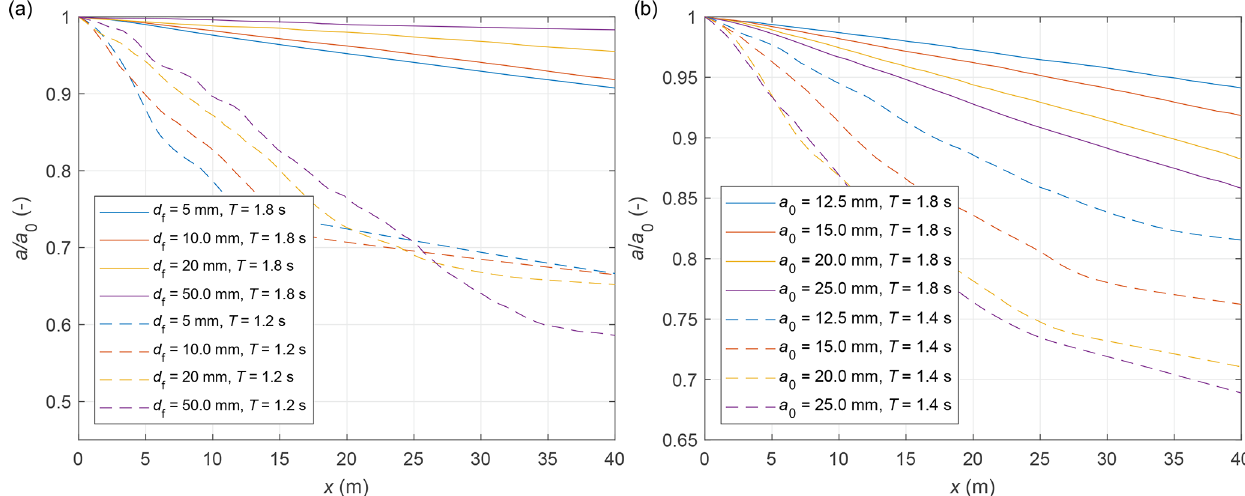
Figure 6. Computed relative wave amplitude a/a 0 for simulations with different average floe–floe distance d f (a) and different incident wave amplitude a 0 (b) , for L x = 0 . 5m, a 0 = 0 . 015m, d f = 0 . 005m, C sd = 0 . 05, and ε = 0 . 6, for two different wave